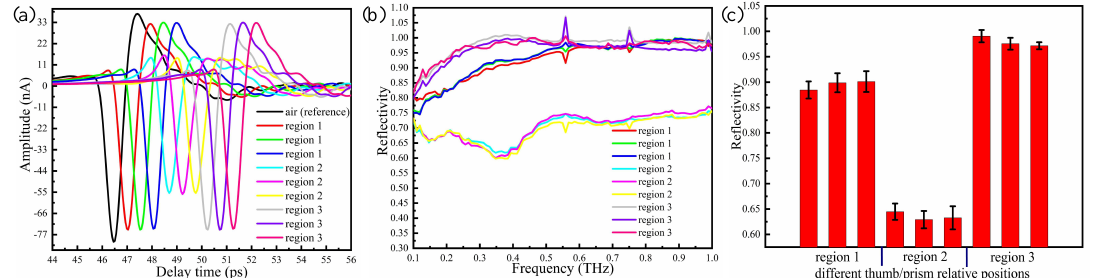
Figure 4. Terahertz (THz)-attenuated total reflection (ATR) spectra with the thumb placed at different regions on the prism: ( a ) the time domain spectra, ( b ) the reflection spectra, ( c ) error tree diagram of the reflectance at 0.3